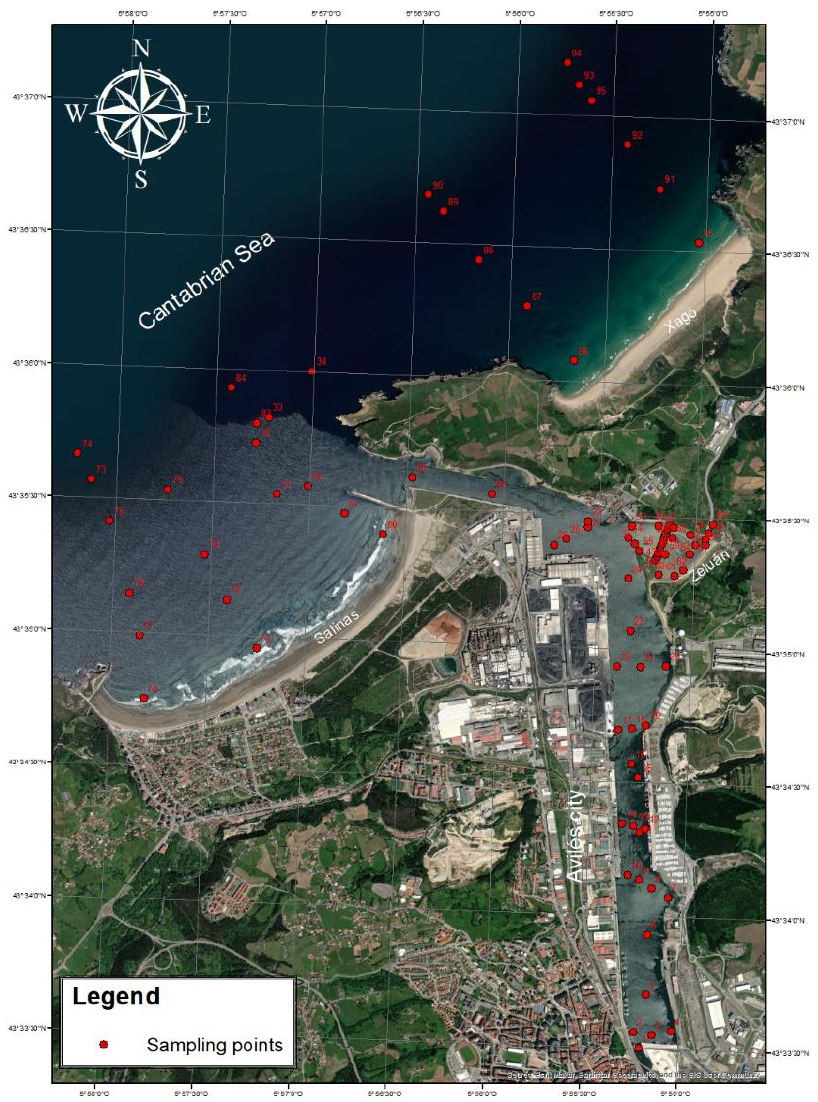
Figure 1. Study area and sampling stations.